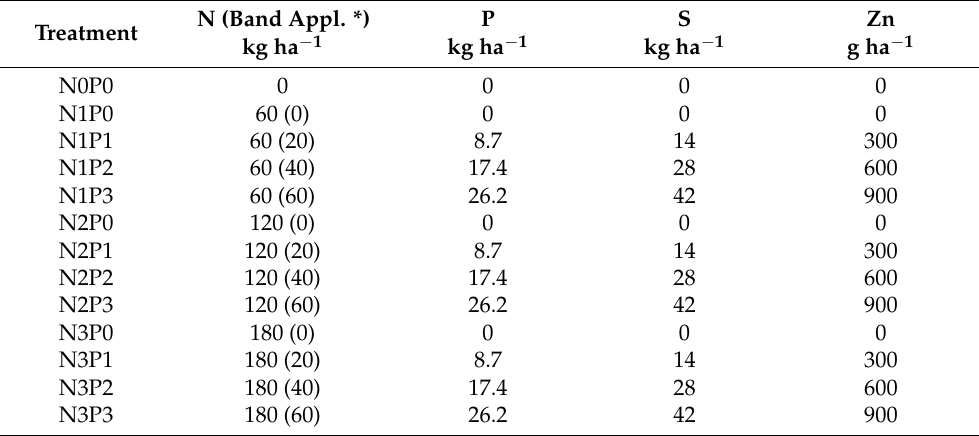
Table 5. Rates of nutrients (N, P, S and Zn) depending on the fertilization treatment. N (Band Appl. Treatment